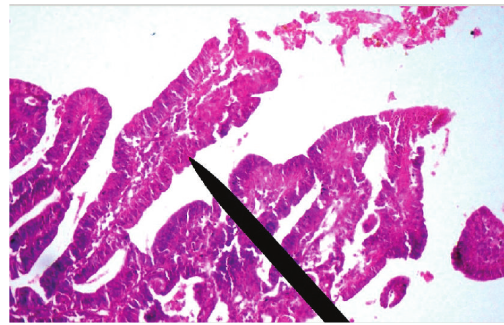
Figure 2: Photomicrograph (400x, H&E stain) of bronchoscopic biopsy showing papillary configuration lined by malignant cells along with prominent fibrovascular core (pointer).